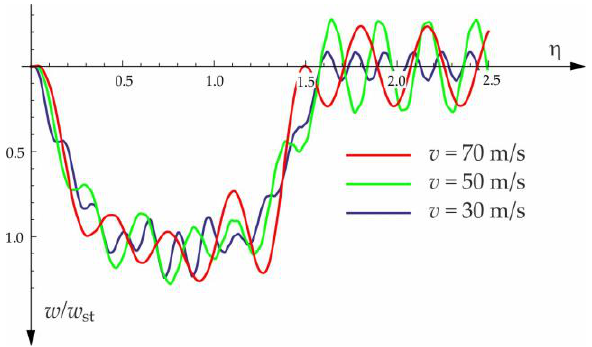
Figure 11. Influence of moving force velocity on deflection of midpoint of the beam on three-parameter Vlasov foundation subjected to a group of two forces moving at a constant distance a = 3 m.